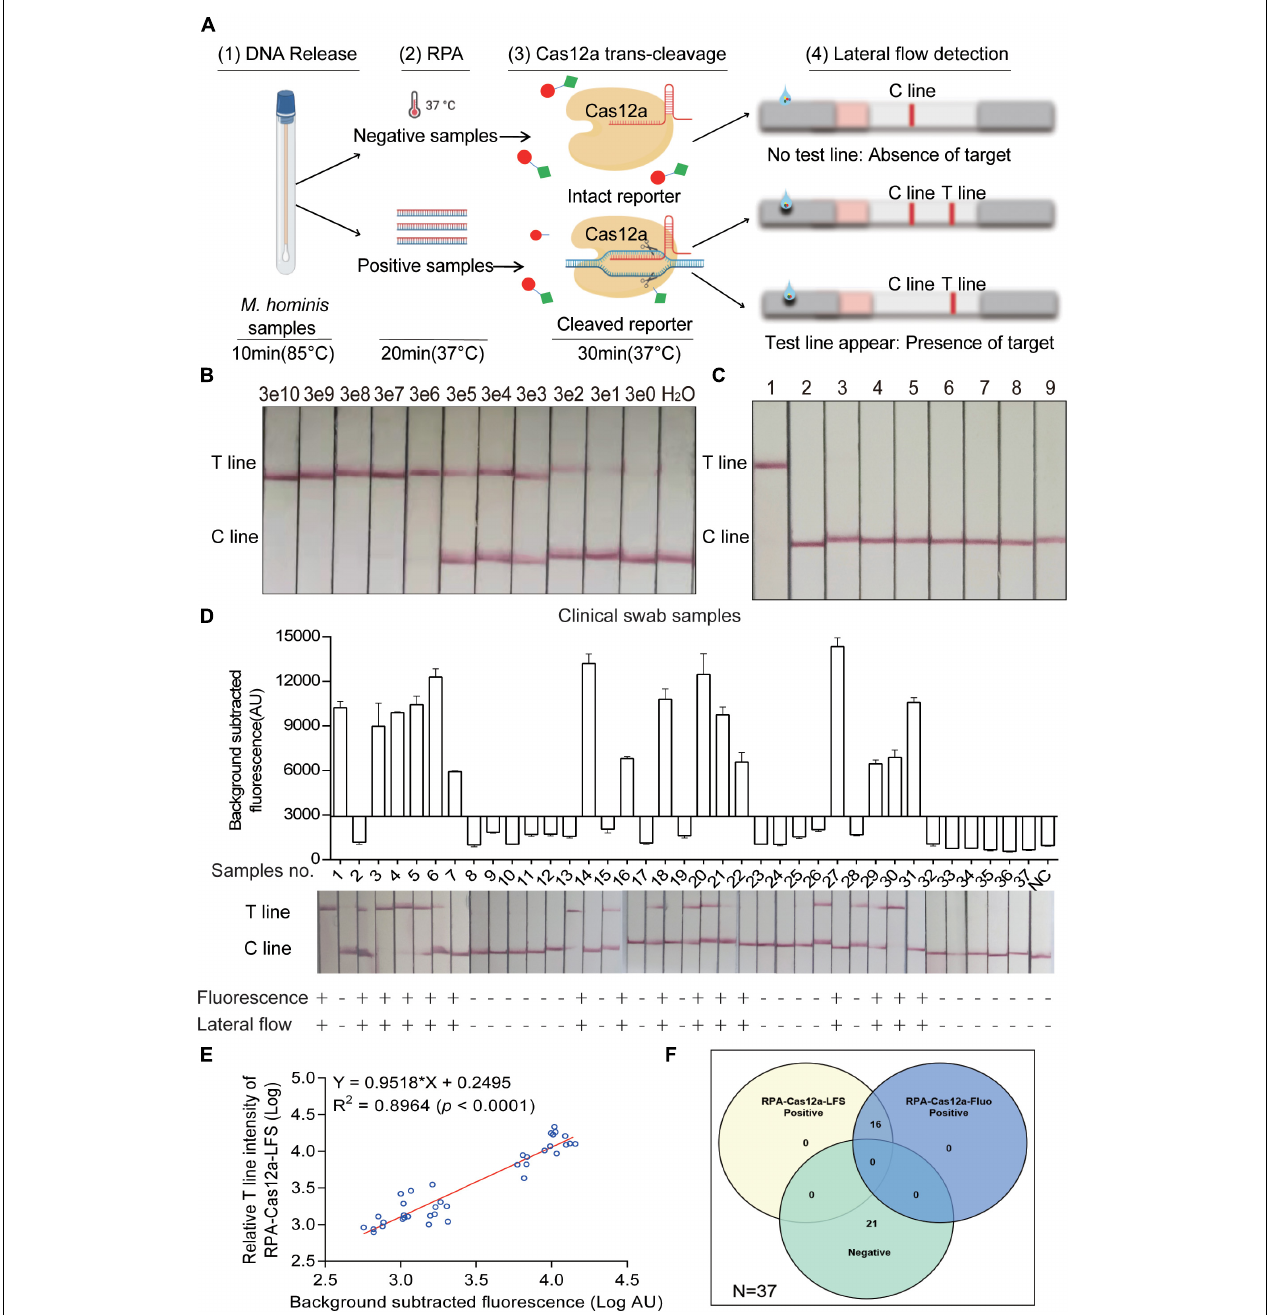
FIGURE 5 | Evaluation and clinical assessment of RPA-CRISPR-Cas12a-lateral flow strip assay (RPA-Cas12a-LFS). (A) Schematic of the RPA-Cas12a-LFS assay for M. hominis detection. (1) DNA was released from clinical samples by rapid lysis for 10 min. (2) RPA amplification for 20 min. (3) Cas12a reaction with the RPA product. (4) Cas12a reaction mixture was loaded onto LFS. T line will appear with the presence of target while C line appears with the absence of target. (B) Lateral flow assay result of the pMD19-T-MH gap detected by the RPA-Cas12a-LFS assay with different copies. (C) Lateral flow assay result of different urogenital pathogens detected by the RPA-Cas12a-LFS assay. 1, M. hominis ; 2, C. albicans ; 3, E. coli ; 4, K. pneumoniae ; 5, S. aureus ; 6, S. flexneri ; 7, S. saprophyticus ; 8, U. urealyticum . 9, H 2 O. (D) RPA-Cas12a-LFS results of 37 clinical samples were compared to RPA-Cas12a-Fluo. (E) The correlation analysis of M. hominis detection results generated by RPA-Cas12a-Fluo assay and RPA-Cas12a-LFS assay. The relative T line intensity was scanned and measured by ImageJ. Both the fluorescence value and the relative T line intensity were logarithmically transformed. (F) The Venn diagram shows the consistency between the RPA-Cas12a-Fluo assay and the RPA-Cas12a-LFS assay. The data are presented as the mean ± SD from three independent experiments. RPA, recombinase polymerase amplification; T line, test line; C line, control